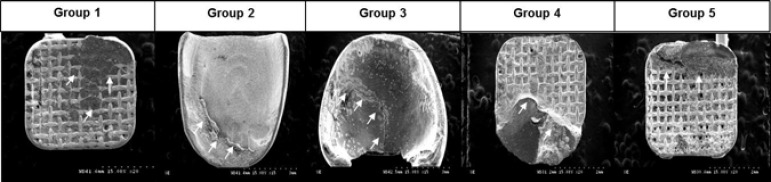
SEM imagines of bracket base after debonding.The resin cement remaining on the bracket base was pointed by the white arrows. The resin cement penetration within metal bracket mesh are shown in group 1, 4, and 5. Group 5 showed the most air voids compared with group 1 and 4. Group 2 showed a small amount on the bottom of bracket. Although a break line was evident, the resin cement completely covered all the surface of the bracket base in group 3. Group 1, preadjusted bracket; Group 2, Harmony; Group 3, Incognito; Group 4, Insignia; Group 5, Orapix.